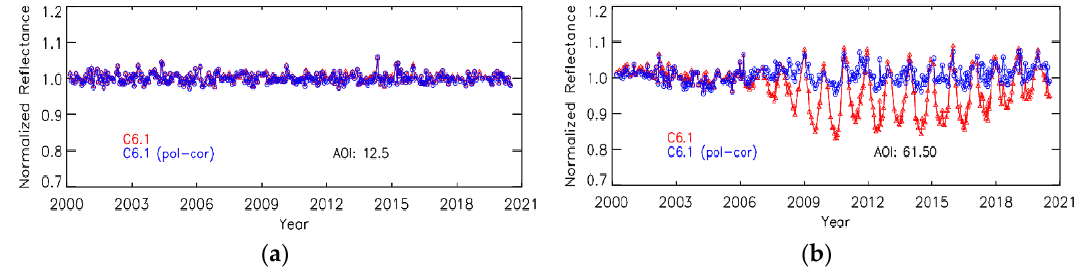
Figure 15. Normalized reflectance trends of Terra MODIS band 8 over select desert sites at angles of Figure15. NormalizedreflectancetrendsofTerraMODISband8overselectdesertsitesatanglesofincidence incidence (AOI) of 12.5° ( a ) and 61.5° ( b ). Red: Before polarization correction; Blue: After polarization (AOI) of 12.5 ◦ ( a ) and 61.5 ◦ ( b ). Red: Before polarization correction; Blue: After polarization correction.